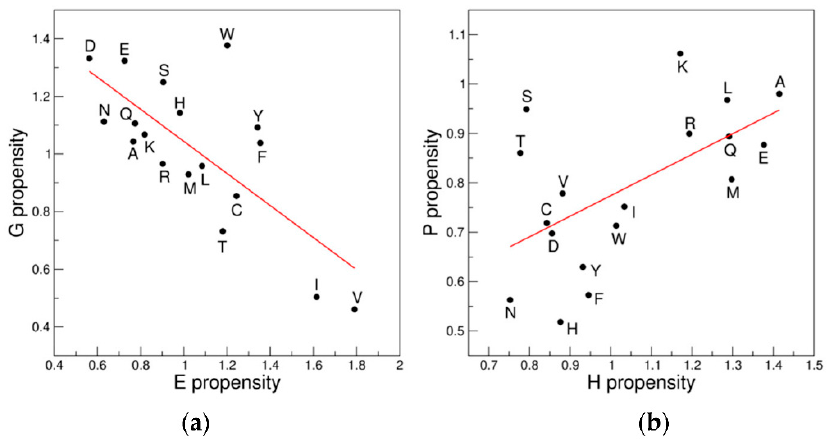
Figure 7. Significant correlation/anticorrelations of the propensity scales detected in the 18AA ensemble: ( a ) E versus G; and ( b ) H versus P.